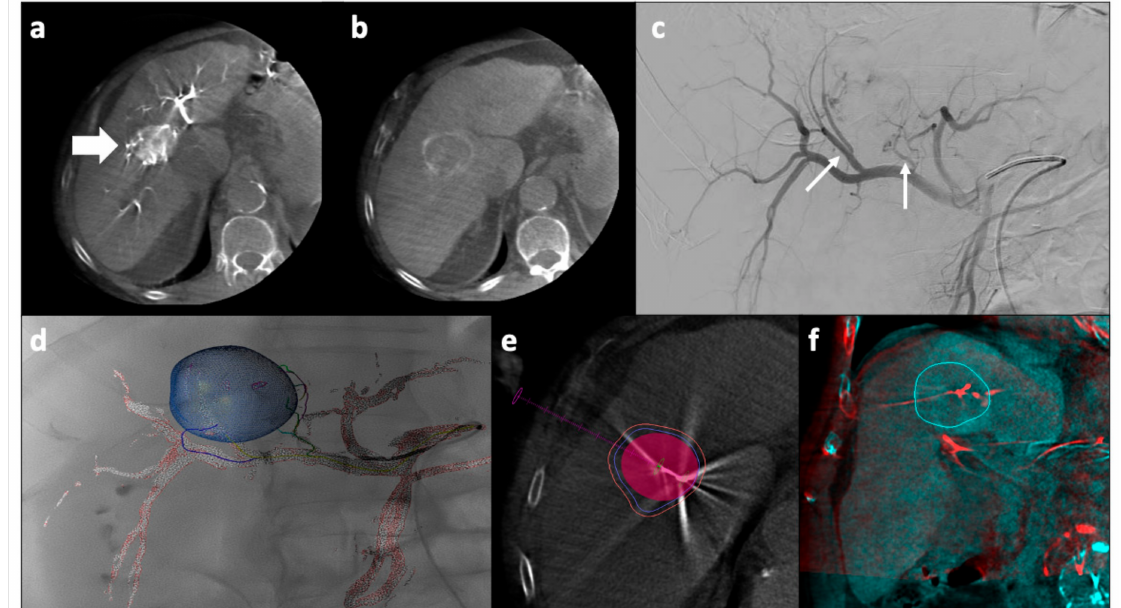
Figure 3. Percutaneous microwave ablation and trans-arterial chemoembolization for a large HCC nodule. For treating large single HCC nodules, a combination of ablation and embolization may be used. After arterial femoral access and catheterization of the celiac trunk and hepatic artery, a CBCT is performed that confirms the presence of a large nodule with arterial wash-in ( a , arrow) and venous wash-out ( b ), consistent with HCC. The angiographic study demonstrated the presence of two main arterial feeders (thin arrows, c ). Dedicated software can be used to delineate the target vessels and to plan the endovascular procedure ( d ). A dedicated software is also available to predict the ablation volume which is virtually created on a CBCT performed after having positioned the antenna inside the tumor, before starting the ablation ( e , f ). CBCT: cone-beam computed tomography; HCC: hepatocellular